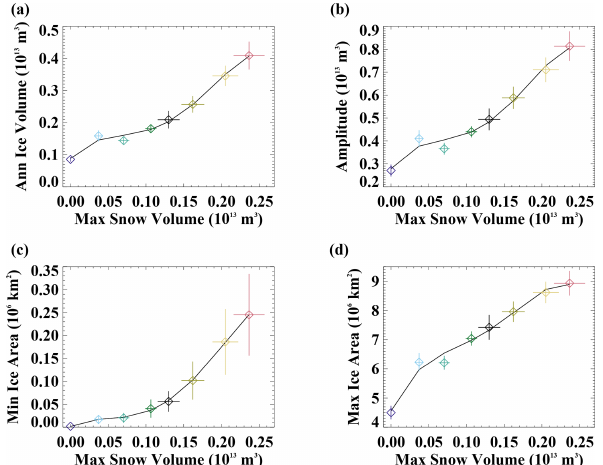
Figure 13. As in Fig. 12 but for Southern Hemisphere values in the 2xCO2